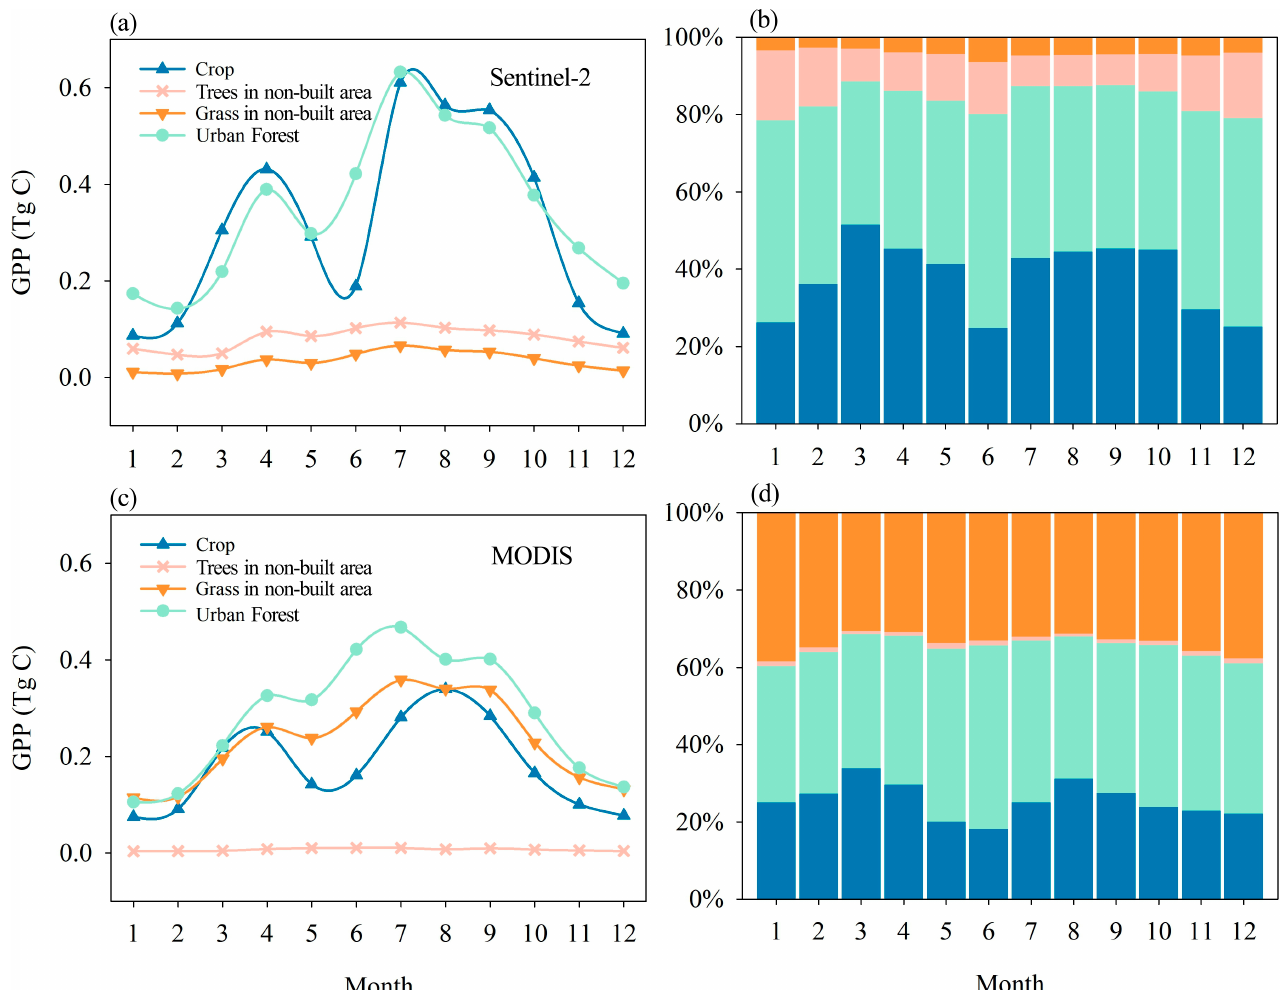
Figure 7. The Sentinel-2 and MODIS GPP changes in different land cover types in 2021 ( a , c ) and their contribution to total GPP ( b , d ).